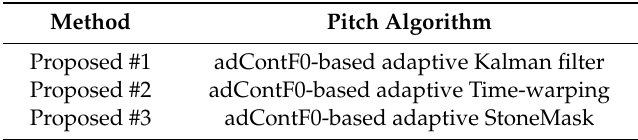
Table 4. An overview of the three proposed methods based on HNR parameters.